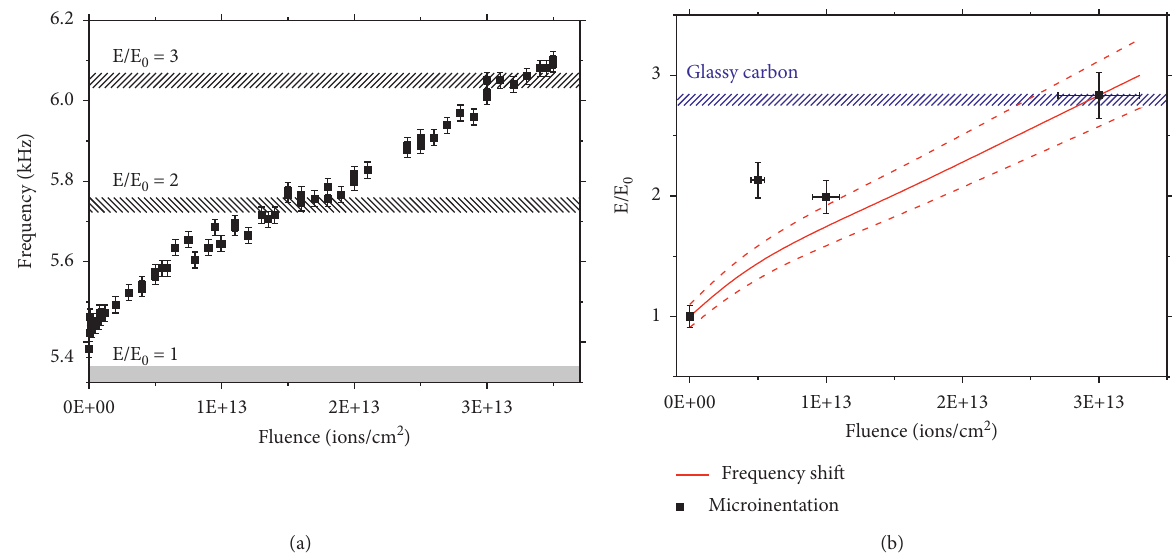
Figure 6: (a) Measured bending frequency of isotropic SGL R6650 graphite as a function of 1.14GeV U-ion accumulated fluence. Shaded areas represent the frequencies obtained by ANSYS simulations with pristine properties as well as with 2 and 3 times the pristine Young’s modulus in the beam spot. The uncertainty of the frequencies of 0.02kHz is obtained by the frequency resolution of the FFT. (b) Relative increase of Young’s modulus as a function of the U-ion fluence measured by microindentation and deduced from simulations of frequency shifts of LDV velocity signals. Error bars represent the error of the mean value for at least 25 microindentation measurements. The uncertainty of the fluence and of Young’s modulus determined from the frequency shift is estimated to be 10% (red dashed lines). The shaded blue area represents the ratio of Young’s modulus of the glassy carbon grade HTW SIGRADUR K [31] and SIGRAFINE R6650 [21] taken from the respective data